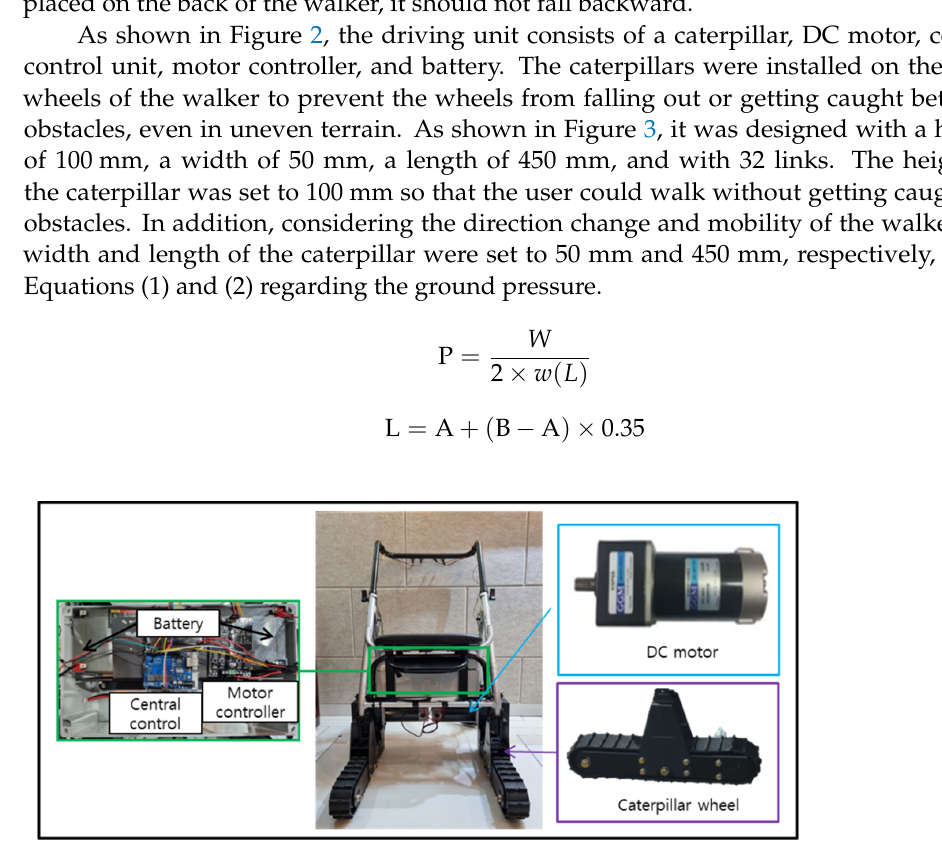
Figure 2. Driving part of caterpillar-type walker.